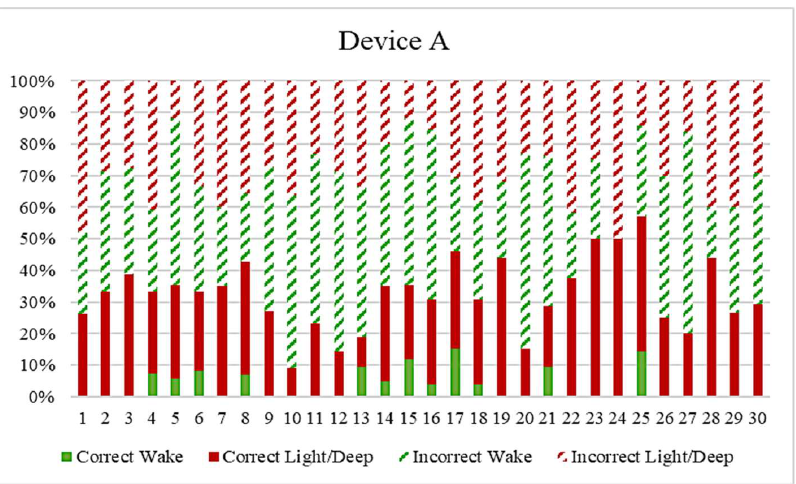
Figure 4. Representative PSG and Device A’s hynograms of a subject with the mismatch from 3:13 to 4:21 a.m.